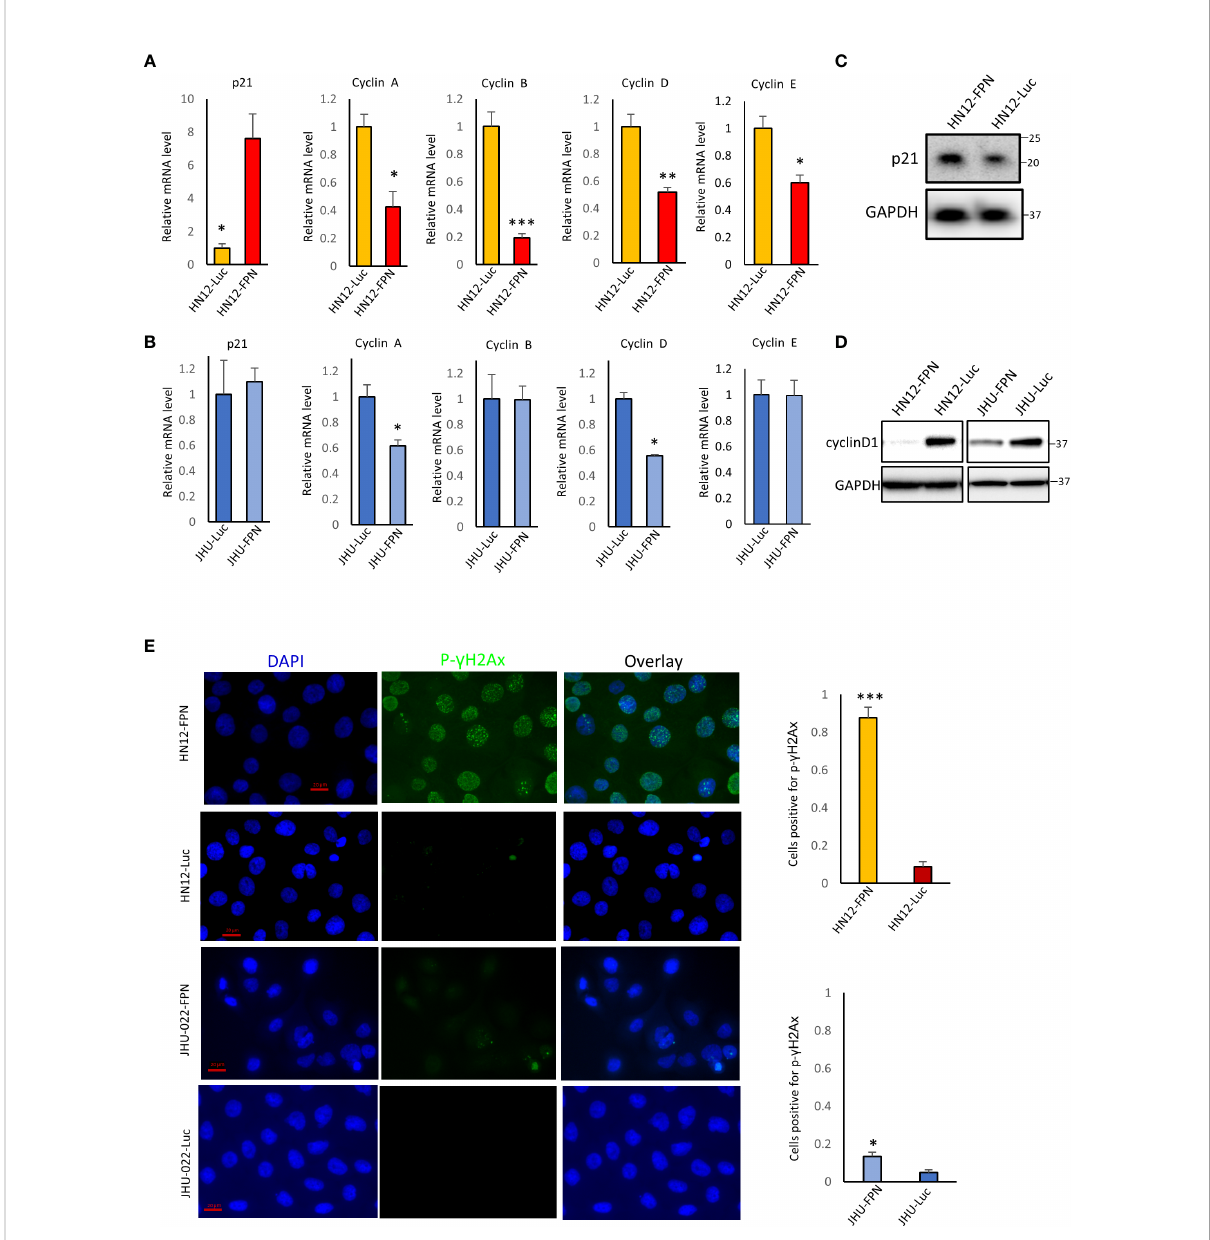
FIGURE 6 Ferroportin expression in HNSCC cell lines downregulates key cell cycle related genes (A) , (B) The mRNA levels of p21, cyclin A, cyclin B, cyclin D and cyclin E were assessed by qRT-PCR in HN12-FPN/Luc and JHU-022-FPN/Luc expressing cells grown in 0.5 m g/mL dox for 3 days. Levels of target genes are normalized to the levels of both GAPDH and beta-actin. Data is representative of 4 technical replicates performed in 3 biological replicates. (C) Western blot of p21 levels in HN12-FPN and HN12-Luc expressing cells. (D) Western blot of cyclinD1 levels in HN12- FPN/Luc and JHU-022/Luc expressing cells grown in 0.5 m g/mL dox for 3 days (E) HN12-FPN/Luc and JHU-022-FPN/Luc cells were stimulated with 0.5 m g/mL dox for 3 days and stained for p- g H2Ax (green) or DAPI (blue). Graphs represent the ratio of cells + for staining over the total number of quanti fi ed cells. Images are representative of 3 biological replicates. (*P<0.05; **P<0.01;